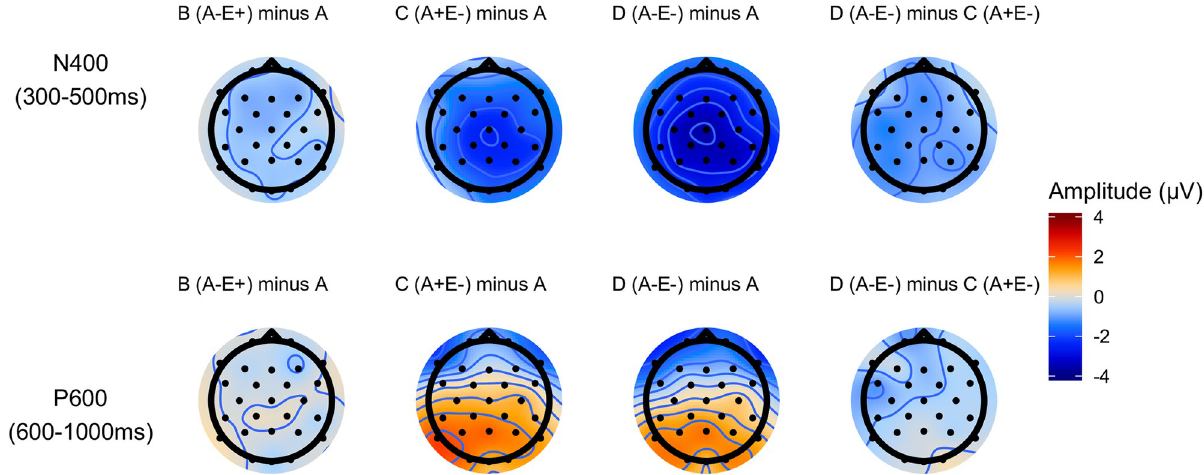
Fig 2. Scalp distributions. Topographic distributions of the average potentials in the N400 (row 1) and P600 time windows (row 2), relative to the baseline condition (columns 1-3) or relative to the unexpected-associated condition (column 4). Topographies computed from all non-reference